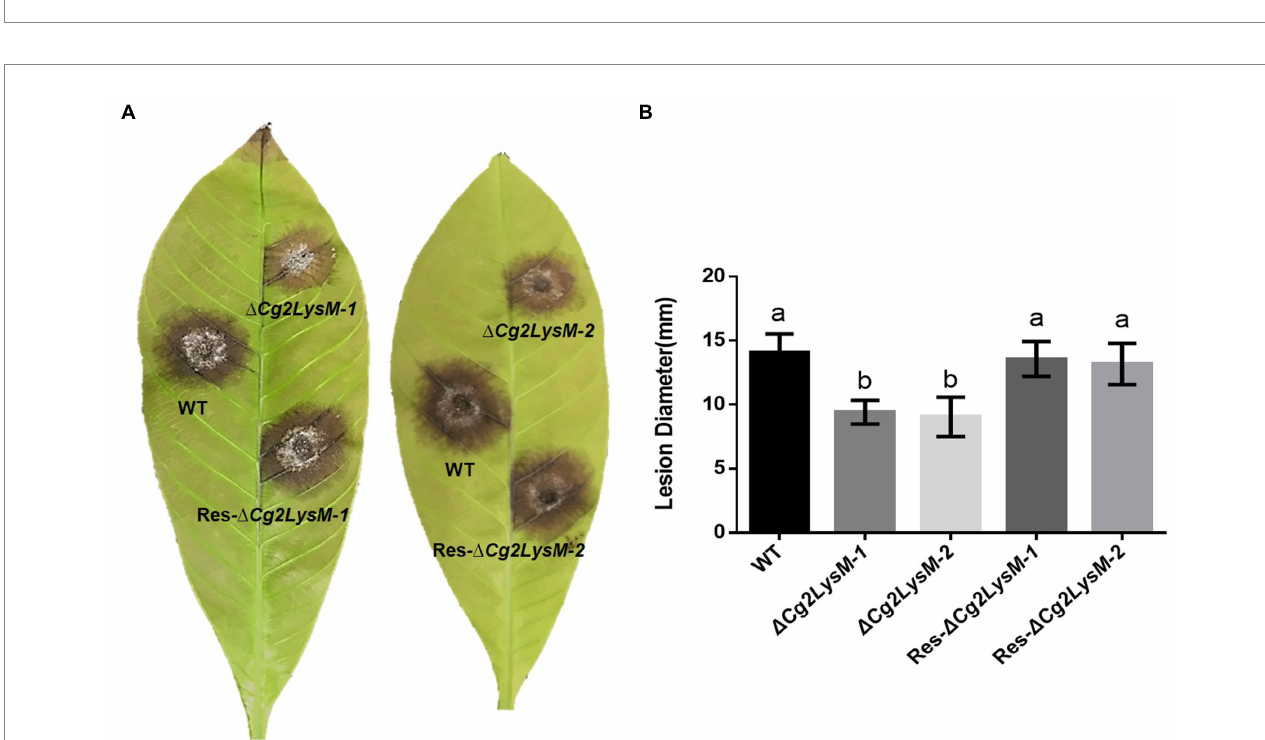
FIGURE 2 Pathogenicity test of WT, Δ Cg2LysM and Res- Δ Cg2LysM on rubber tree leaves. (A) Disease symptoms on rubber tree ( Hevea brasiliensis ) leaves at 4 days post inoculation with WT, Δ Cg2LysM and Res- Δ Cg2LysM . (B) Statistic analysis of lesion diameter at 4 days post inoculation with WT, Δ Cg2LysM and Res- Δ Cg2LysM . Data are shown as the means ± SD from three independent experiments and at least 20 infections per experiment. Different letters above columns indicate a significant difference ( p <